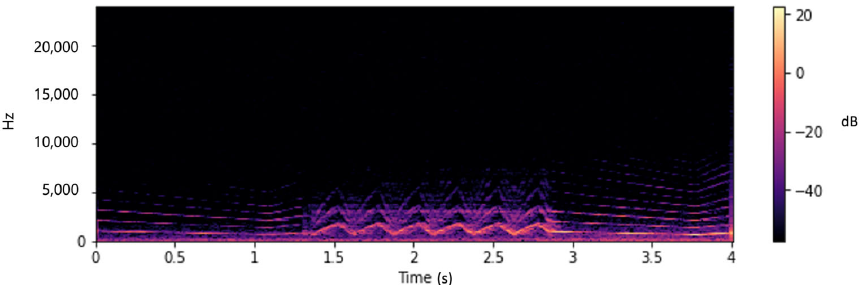
Figure 6. Concrete pouring sound data at a construction site: sound spectrum.